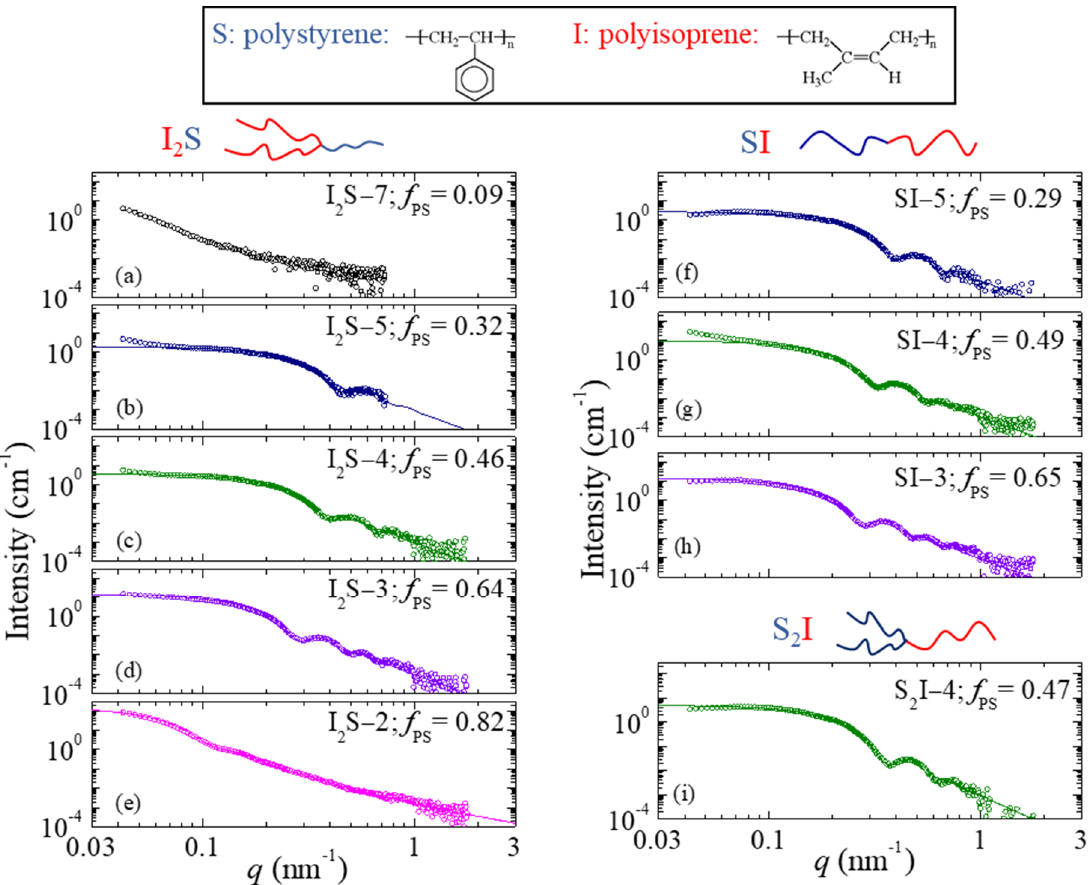
Figure 1. Small-angle x-ray scattering intensity profiles for the 2 wt% blends of ( a – e ) the various I 2 S graft copolymers and ( f – h ) the linear SI diblock copolymers and ( i ) the S 2 I−4 graft within a low molecular weight polyisoprene homopolymer matrix at room temperature. The corresponding best fits are shown by solid lines. Schematics that illustrate the chemical structures of all polymers studied in this work are included.